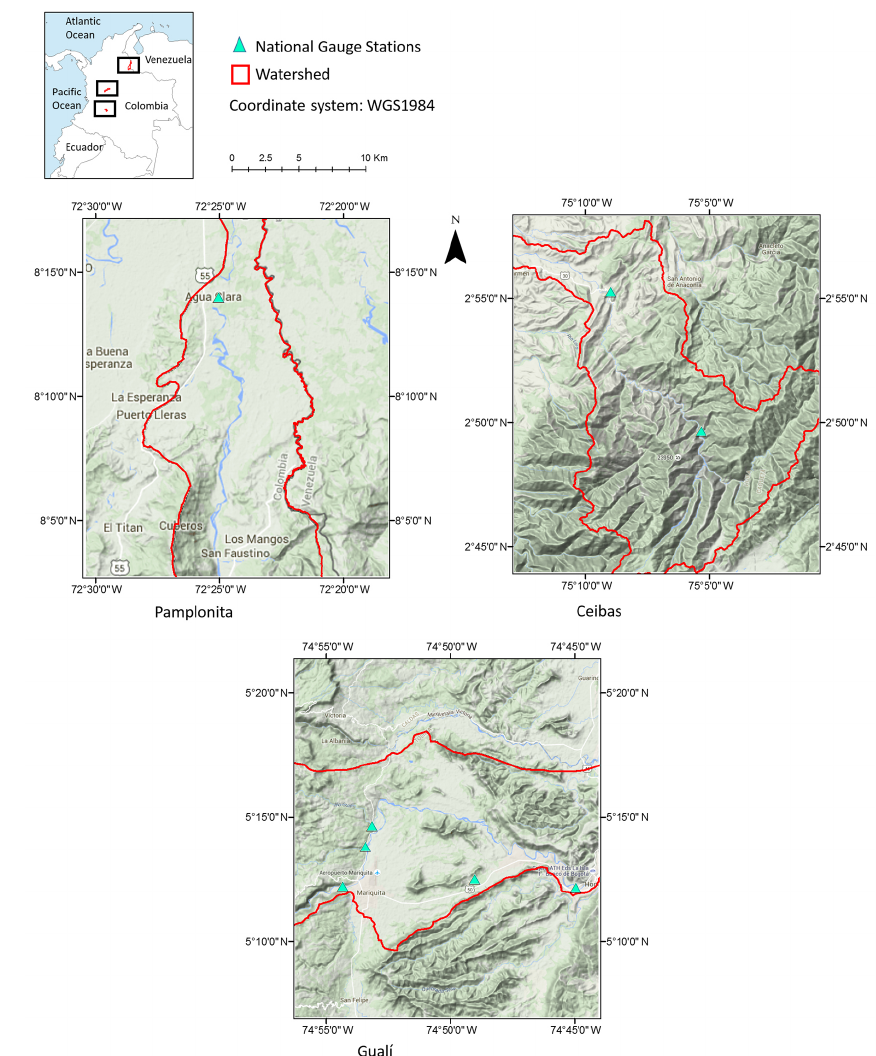
Figure 3. Location of the Pamplonita, Ceibas and Gualí catchments in